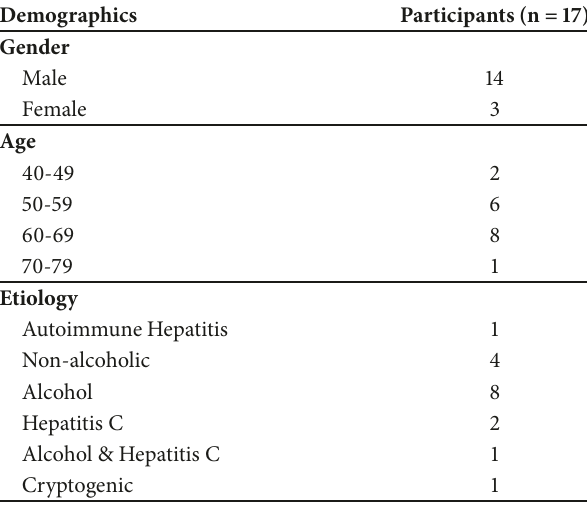
Table 2: Participant demographic